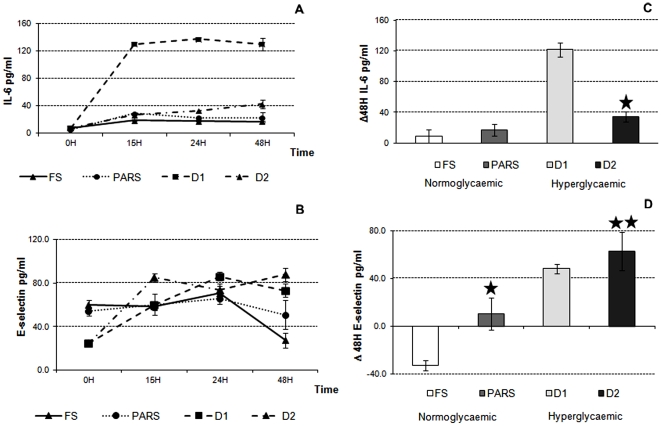
Medium IL-6 and E-selectin
in the 3-way cultures in FS, PARS, D1 and D2 conditions. A) IL-6 variations over time. B) Summary of the changes in Il-6 concentrations over 48 H (* = p<0.05 vs. D1). C) E-selectin variations over time. D) Summary of the changes in E-selectin concentrations over 48 H (* = p<0.05 vs. FS, ** = p<0.05 vs. D1). Time 0 represents the levels of markers in fresh media. Data are expressed as means ± SD (3≤n≤6). Error bars represent the standard deviation.